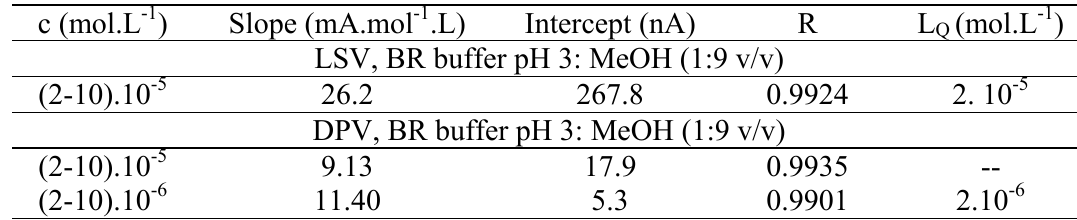
Table 2. Calibration data for voltammetric determination of 1-NP at GCPE. c (mol.L -1 )